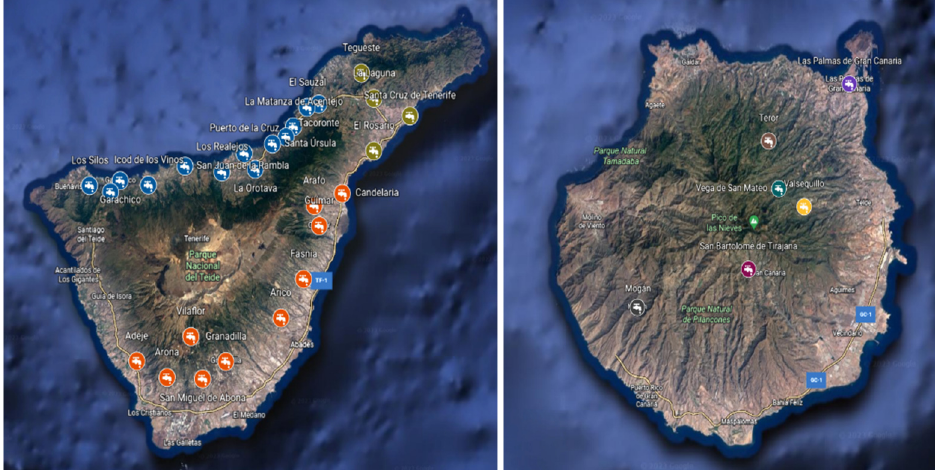
Figure 2. Sampling locations in Tenerife and Gran Canaria islands (obtained from Google Earth™ software). Table 1 . Areas sampled on the island of Tenerife and the island of Gran Canaria .